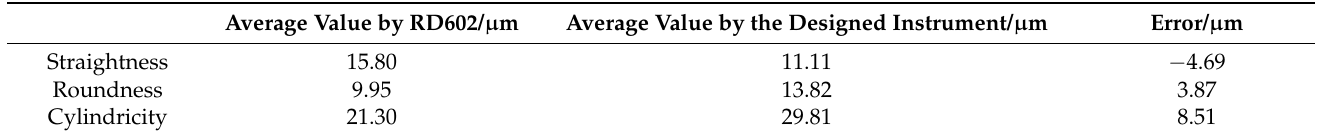
Figure 21. Workpiece form deviation measurement by cylindricity measuring instrument RD602. Table 4. Comparison of deviation results.